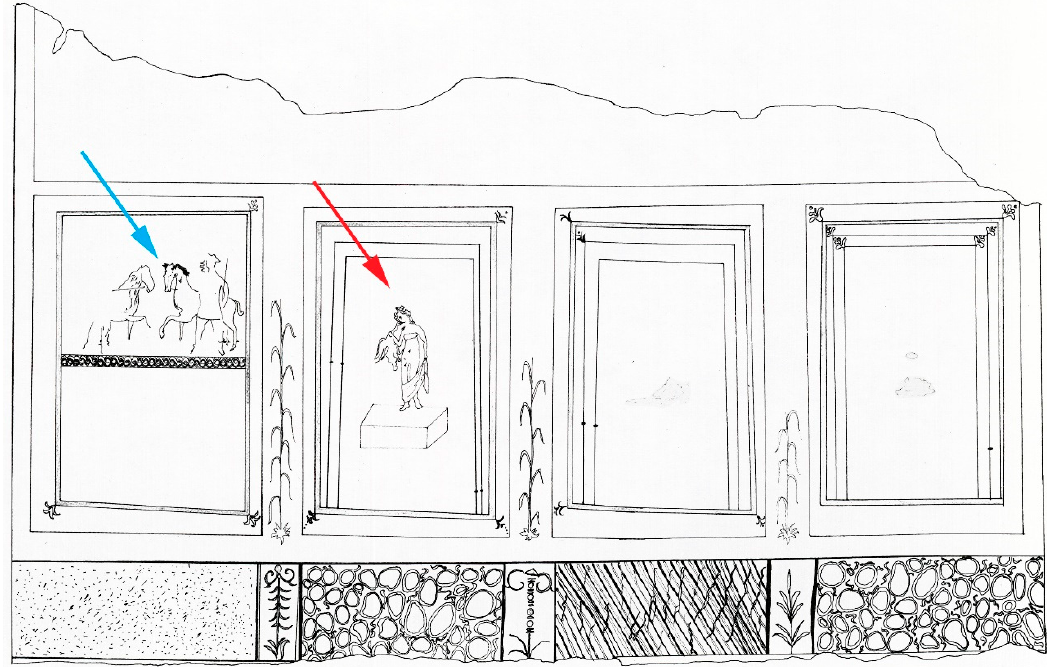
Figure 7. Soluntum, House of Leda, northern wall of triclinium g, Castor and Pollux (blue) and Leda and the Swan (red), schematic drawing (after De Vos 1975, p. 217).